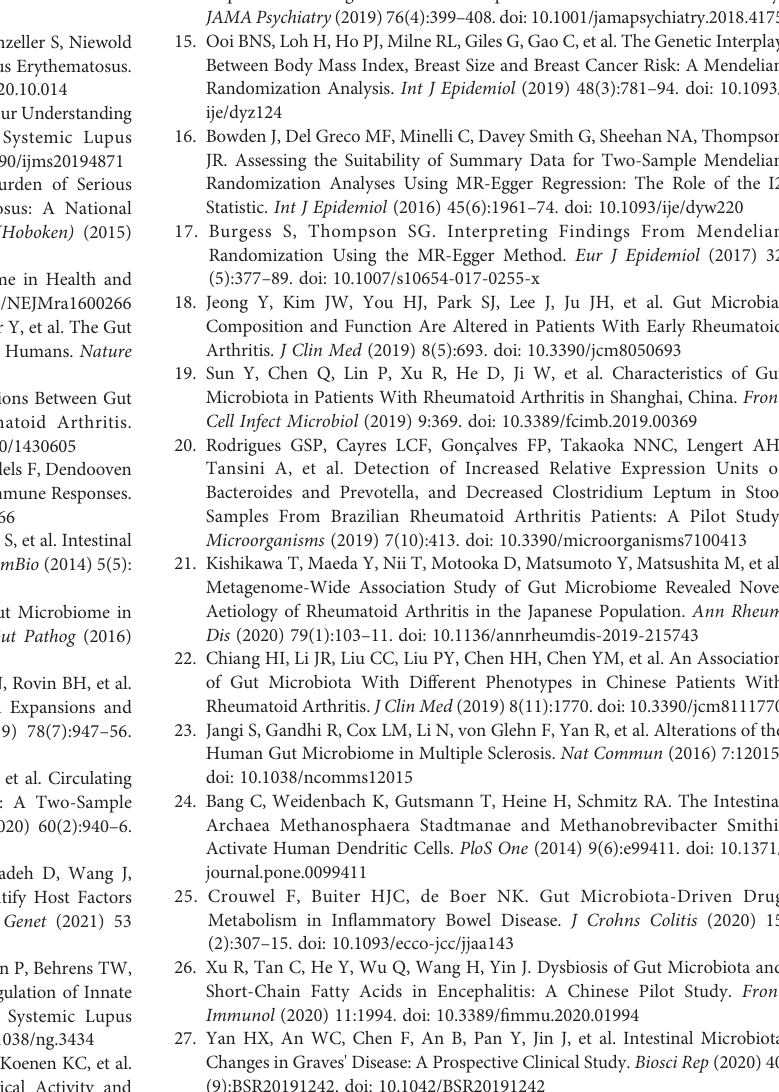
Supplementary Figure 1 | Forest plot (A) , sensitivity analysis (B) , scatter plot (C) , and funnel plot (D) of the causal effect of Eggerthella on SLE risk. Supplementary Figure 2 | Forest plot (A) , sensitivity analysis (B) , scatter plot (C) , and funnel plot (D) of the causal effect of Lactobacillales on SLE risk. Supplementary Figure 3 | Forest plot (A) , sensitivity analysis (B) , scatter plot (C) , and funnel plot (D) of the causal effect of Coprobacter on SLE risk. Supplementary Figure 4 | Forest plot (A) , sensitivity analysis (B) , scatter plot (C) , and funnel plot (D) of the causal effect of Bacillales on SLE risk. Supplementary Figure 5 | Forest plot (A) , sensitivity analysis (B) , scatter plot (C) , and funnel plot (D) of the causal effect of Lachnospira on SLE risk. Supplementary Figure 6 | Forest plot (A) , sensitivity analysis (B) , scatter plot (C) , and funnel plot (D) of the causal effect of the whole gut microbiome on SLE risk ( P < 5 × 10 -8